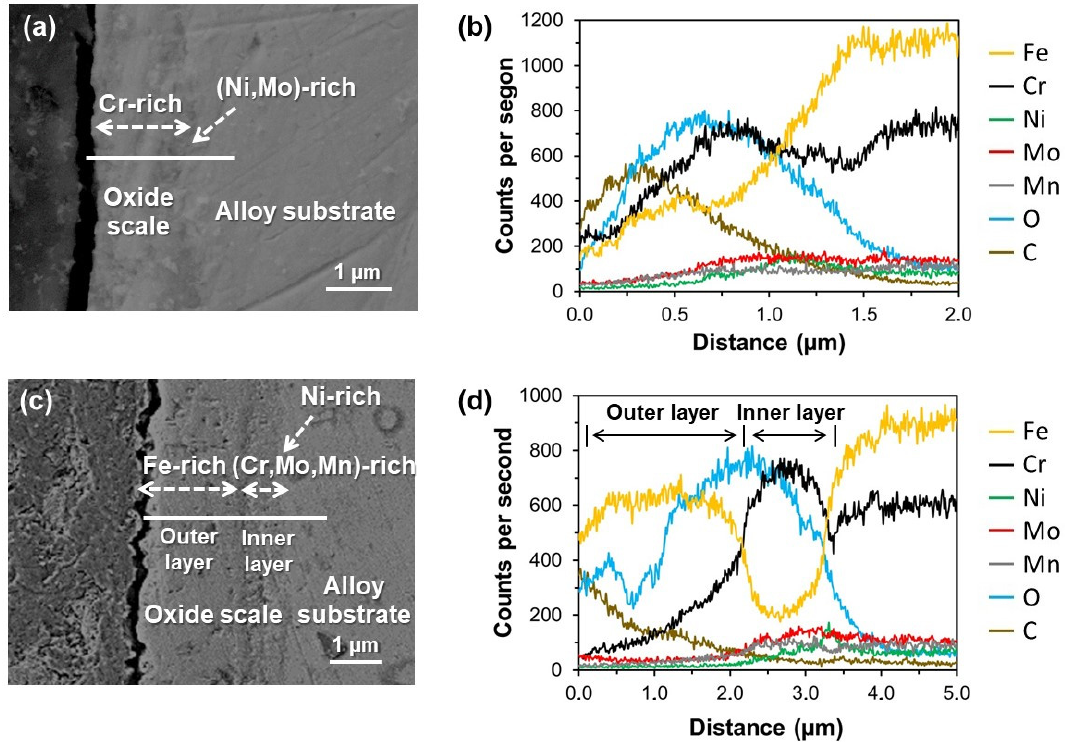
Figure 7. Cross-sectional SEM images and EDS line-scan analyses corresponding to the white line of DS2205 exposed to molten salts for: ( a ) and ( b ) 300 h, and ( c ) and ( d ) 1600 h.